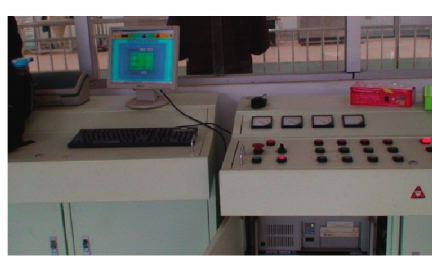
Figure 6: Main console operation